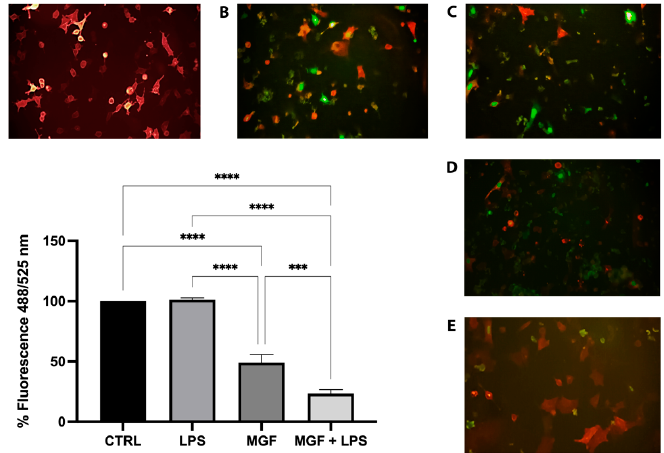
Figure 7. Representative images of pseudo SARS-CoV-2 entry: entry of pseudovirus bearing the green reporter in red fluorescence ACE2-expressing host cells A549. Green fluorescence nucleus was only expressed in cells infected by the pseudovirus; therefore, the amount of green present was proportional to the number of infected cells. ( A ) K cells, A549 transduced with ACE2 BacMam; ( B ) K virus, cells infected by pseudo SARS-CoV-2; ( C ) LPS treated cells ; ( D ) MGF treated cells; ( E ) co- treated MGF + LPS cells. Images obtained at 20X magnification. *** p < 0.001; **** p < 0.0001.